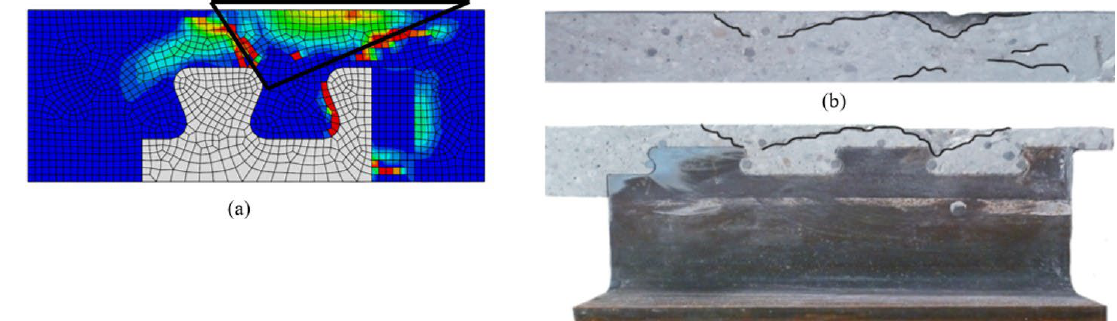
Figure 23. (a) Tensile damage in numerical model; (b) concrete cracking in experiments with puzzle shear connector – Classen and Herbrand [20].